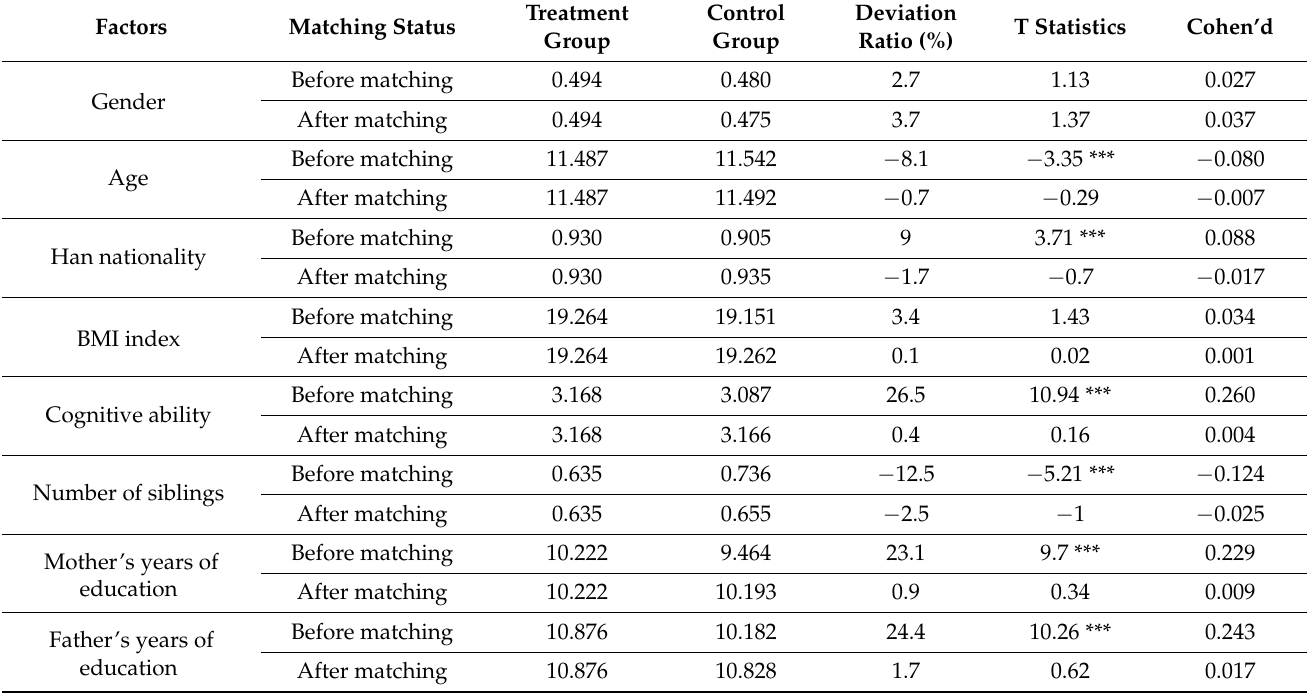
Table 3. Balance test.